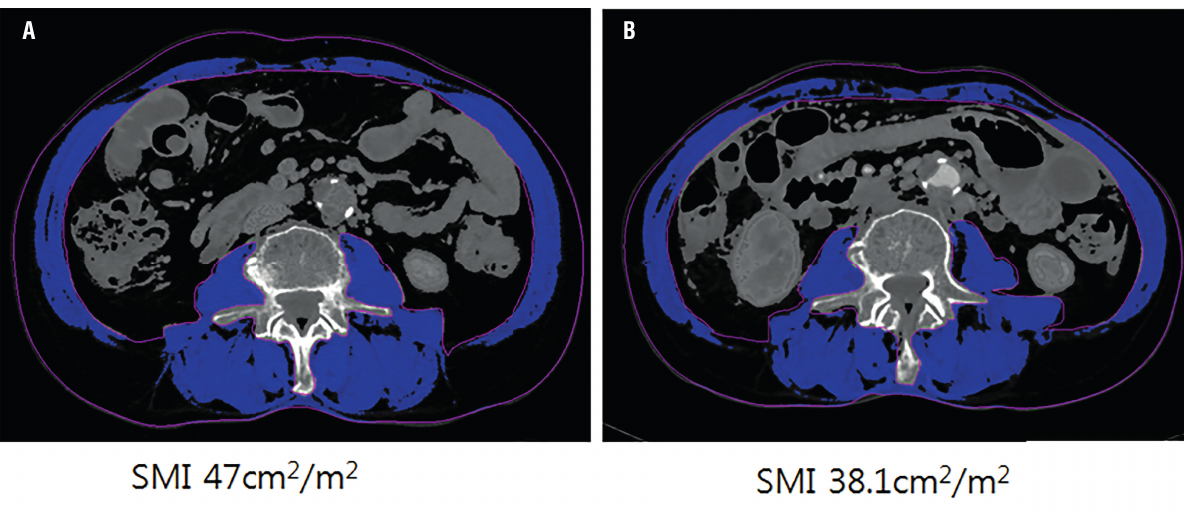
Figure 1 - Representative CT scans with decreased skeletal muscle index (SMI) in an 82-year-old man before (A) and at a mean of one year (B) after radical